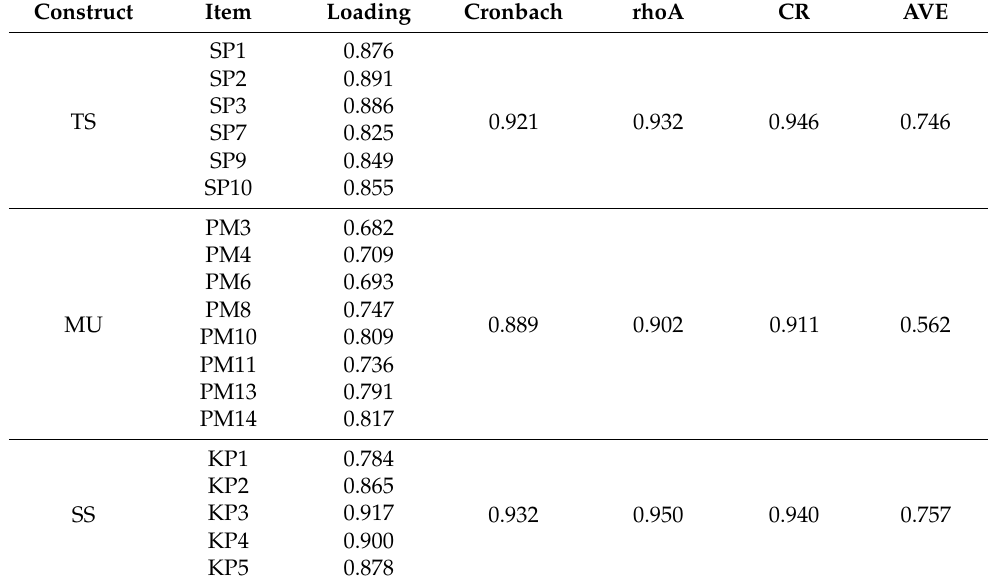
Table 1. Convergent Reliability Test.